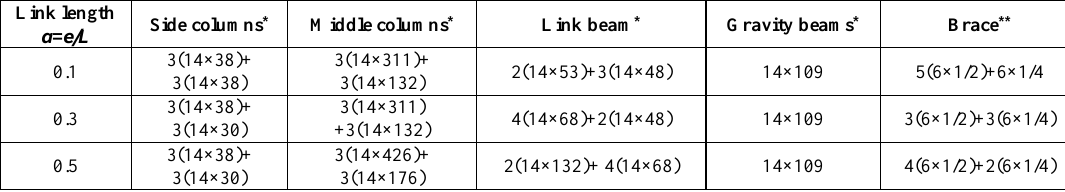
Table 2. Section sizes of the 6St-EBFs in Fakhroddini et al . (Fakhraddini et al . , 2019)